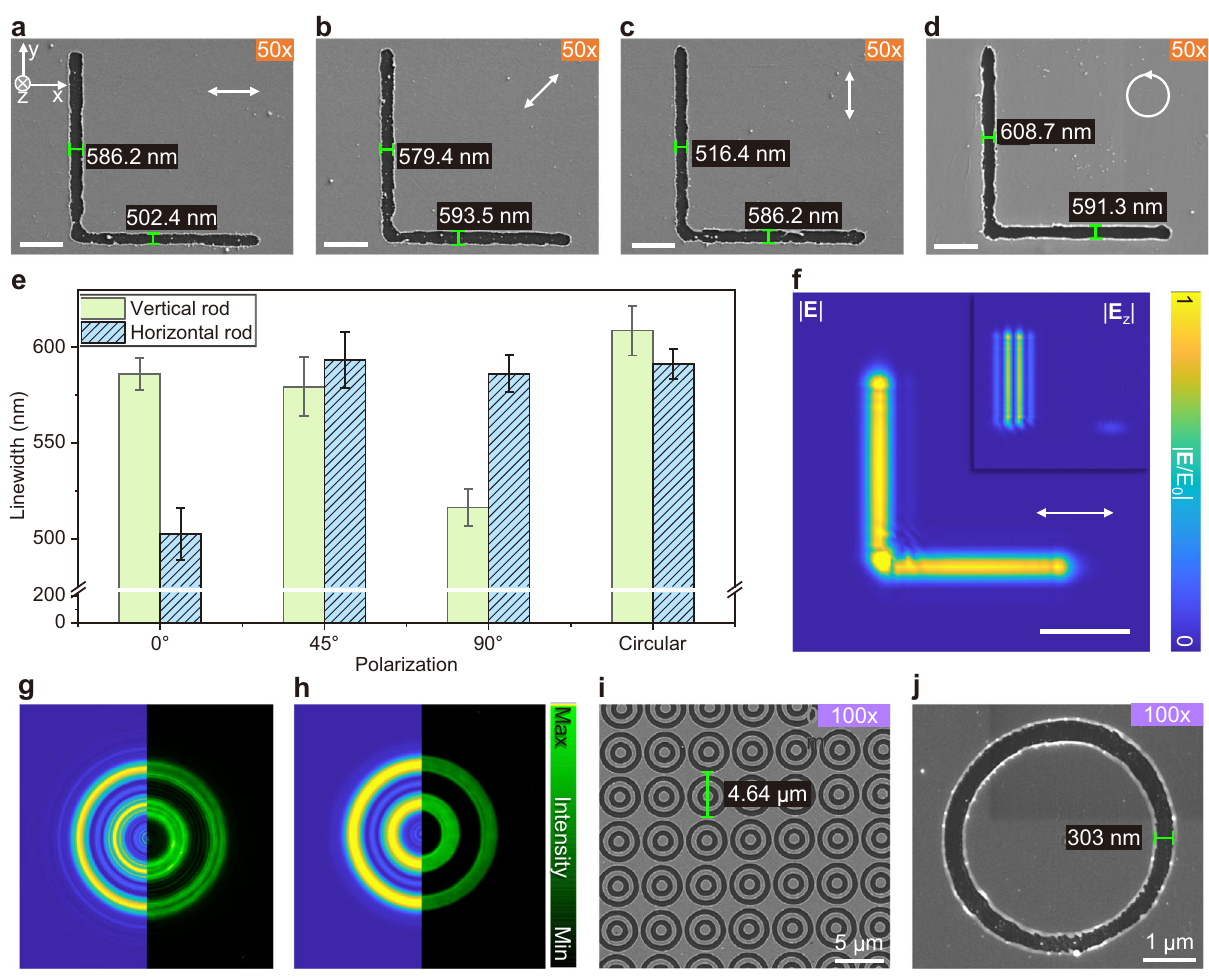
Fig. 3 | The L shapes produced by PPLL with different polarizations and iso- tropic rings made with circular polarization. a – d Ablation result of the gradient boundaryLshapewith20-pixelwidth(with6-pixelgradationoneachboundary)by 0°, 45°, 90°, and circular polarization, respectively. The white arrows indicate the polarization direction. The applied pulse energy is 0.15 μ J. Scale bars: 2 μ m. e The measurementofhorizontalandverticalrods ’ linewidthswithdifferentpolarization states.Theerrorbarsrepresentthestandarddeviationofmeasuredlinewidth. f The